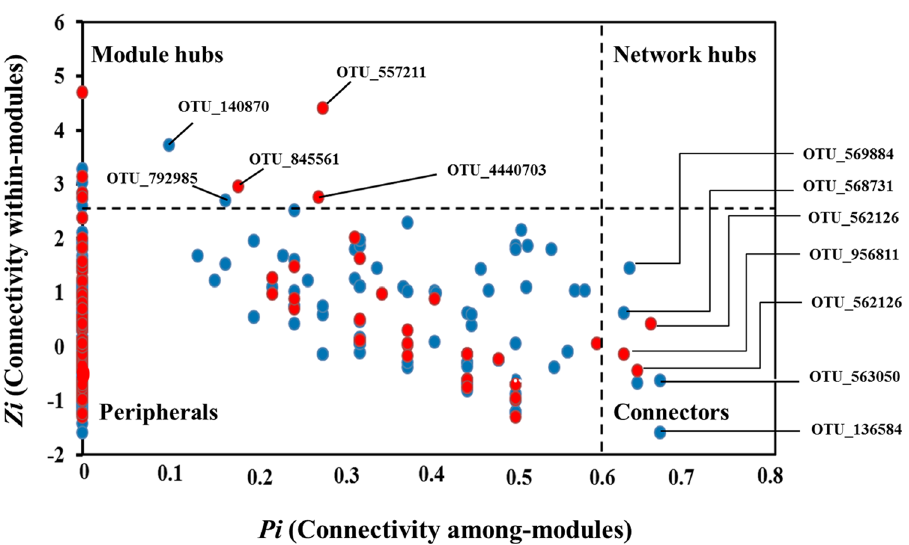
Figure 6. Classification of nodes based on their topological roles. Z-P plot showing distribution of nodes based on their within-module connectivity ( Zi ) and among-module connectivity ( Pi ) values to identify putative keystone taxa in co-occurrence networks of control and thermal discharge-impacted samples. Each dot represents a node belonging to control (blue colour) and thermal discharge-impacted (red colour)